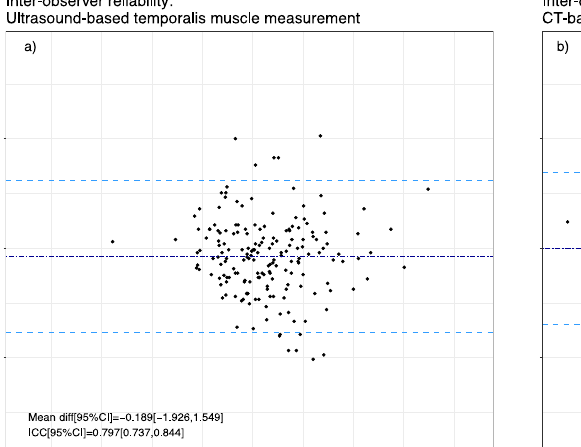
Figure 2. Muscle characteristics. Change in TMT and RFT within the first 20 days of ICU stay. Percent change of muscle thickness in ultrasound-based measurements of TMT (blue line), CT-based TMT (red line), and ultrasound-based RFT (black dotted line). Each measured muscle was treated as a unit of analysis. Correspondingly, n equals double the number of patients included in the study. * p < 0.05; ** p < 0.01; **** p > 0.0001 ( p values for the Wilcoxon signed-rank test for paired samples referencing day 0).